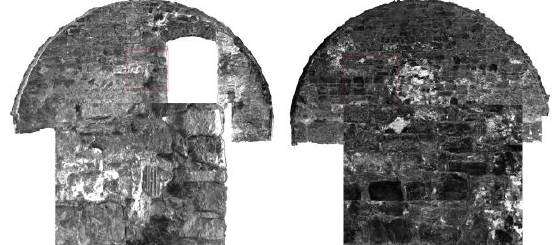
Fig. 7. Distribution of deviations for the plane presented in red in Fig.6